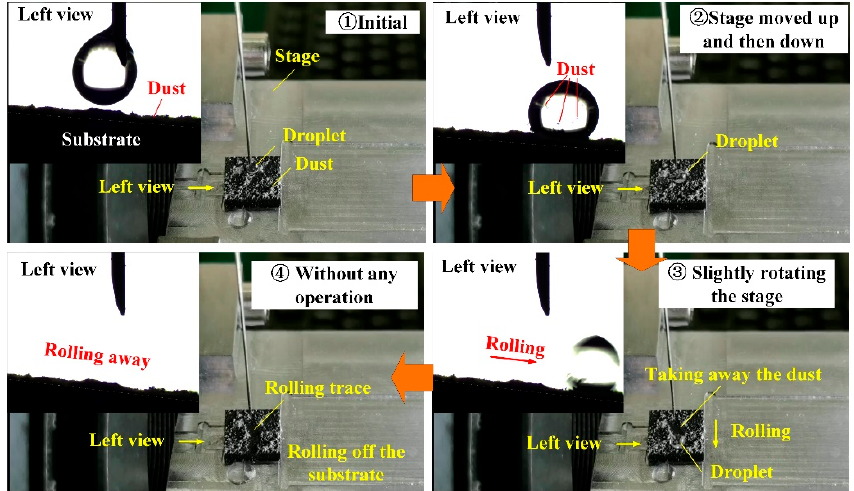
Figure 13. Functional surface with self-cleaning property.